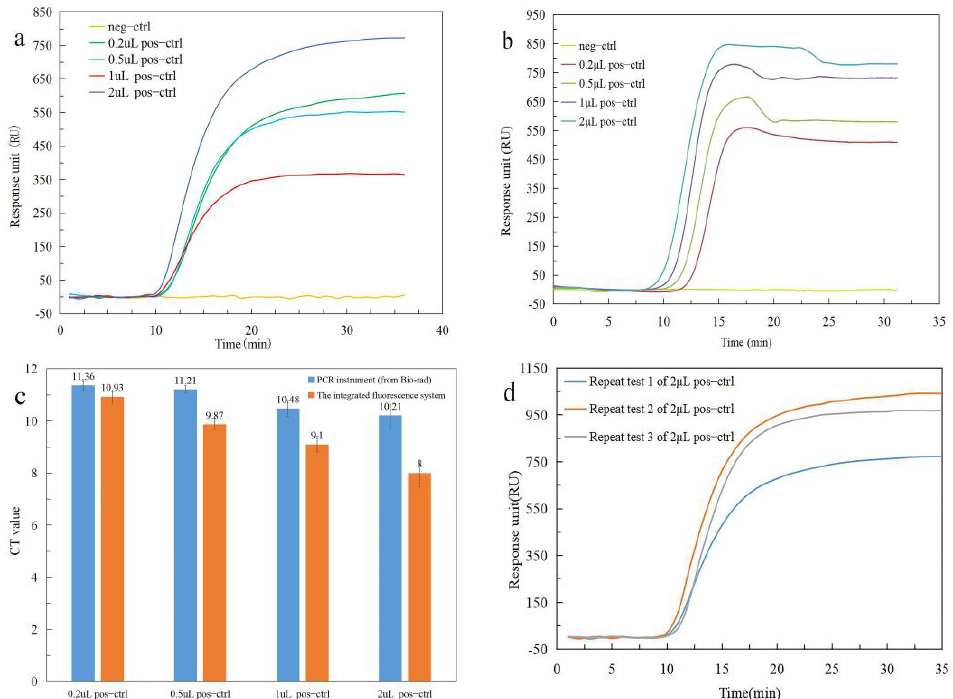
Figure 4. Comparing the LAMP and fluorescence detection results of the independent fluorescence system and the PCR instrument. ( a ) The fluorescence detection process of different concentrations of positive control (pos − ctrl) with PCR instrument (Bio − rad). ( b ) The independent fluorescence detection system on a chip for the same experiments as in Figure 4a. ( c ) CT values of different pos − ctrl with two instruments. ( d ) Comparison of the results of three fluorescence detections using the same concentration of reagent (positive control at a volume of 2 µ L). The CT values were similar, but the final fluorescence responses were very different.